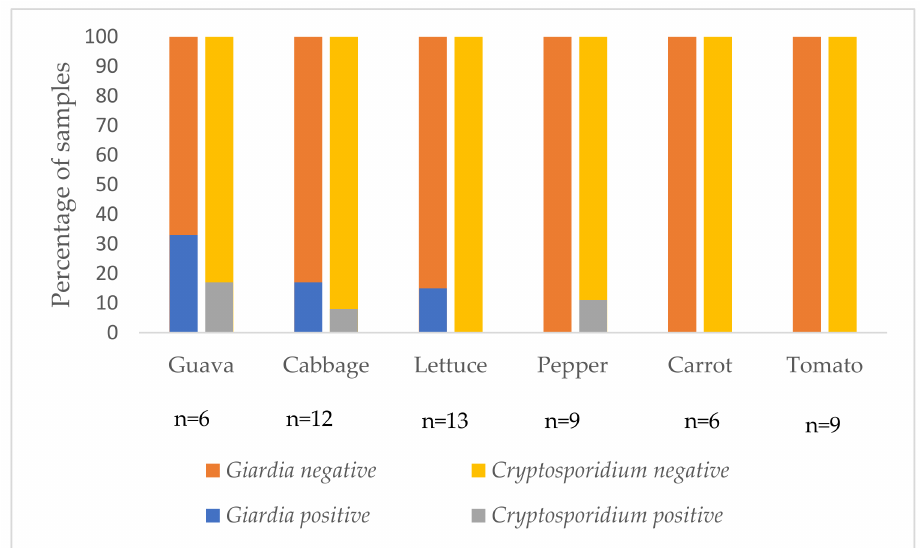
Figure 1. Proportion of Giardia and Cryptosporidium contaminated fresh produce samples. Table 2. Intensity of contamination of fresh produce with Cryptosporidium oocysts and Giardia cysts.